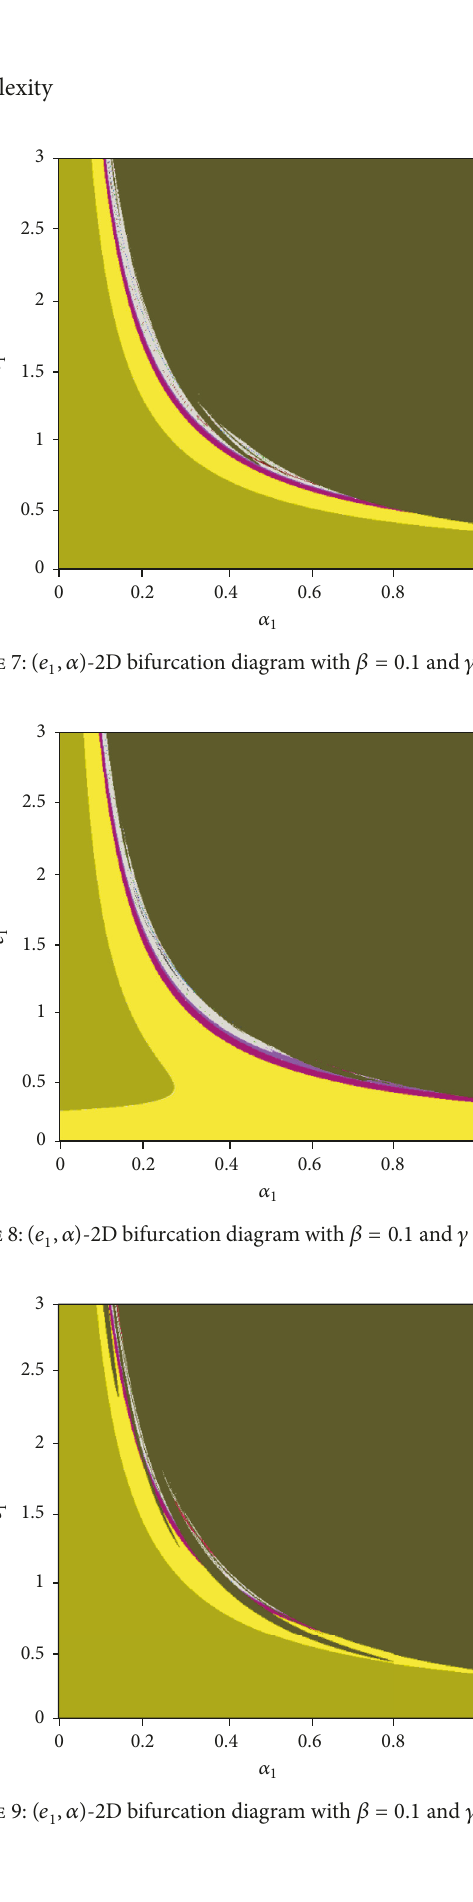
Figure 9: (𝑒 1 , 𝛼) -2D bifurcation diagram with 𝛽 = 0.1 and 𝛾 = 0.3 .